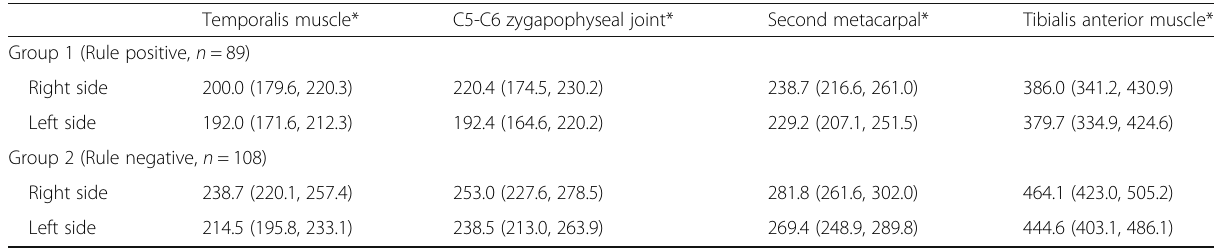
Table 2 Differences in pressure pain thresholds (PPT, kPa) between individuals with tension-type headache by group Temporalis muscle* C5-C6 zygapophyseal joint* Second metacarpal* Tibialis anterior muscle* Group 1 (Rule positive, n = 89) Right side 200.0 (179.6, 220.3) 220.4 (174.5, 230.2) Left side 192.0 (171.6, 212.3) Right side 238.7 (220.1, 257.4) 253.0 (227.6,